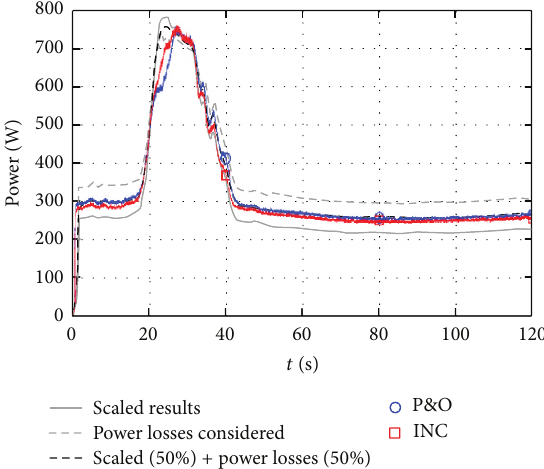
Figure 14: Ambient conditions (irradiance and solar panels tem- perature) during operation of the photovoltaic facility studied from [50].